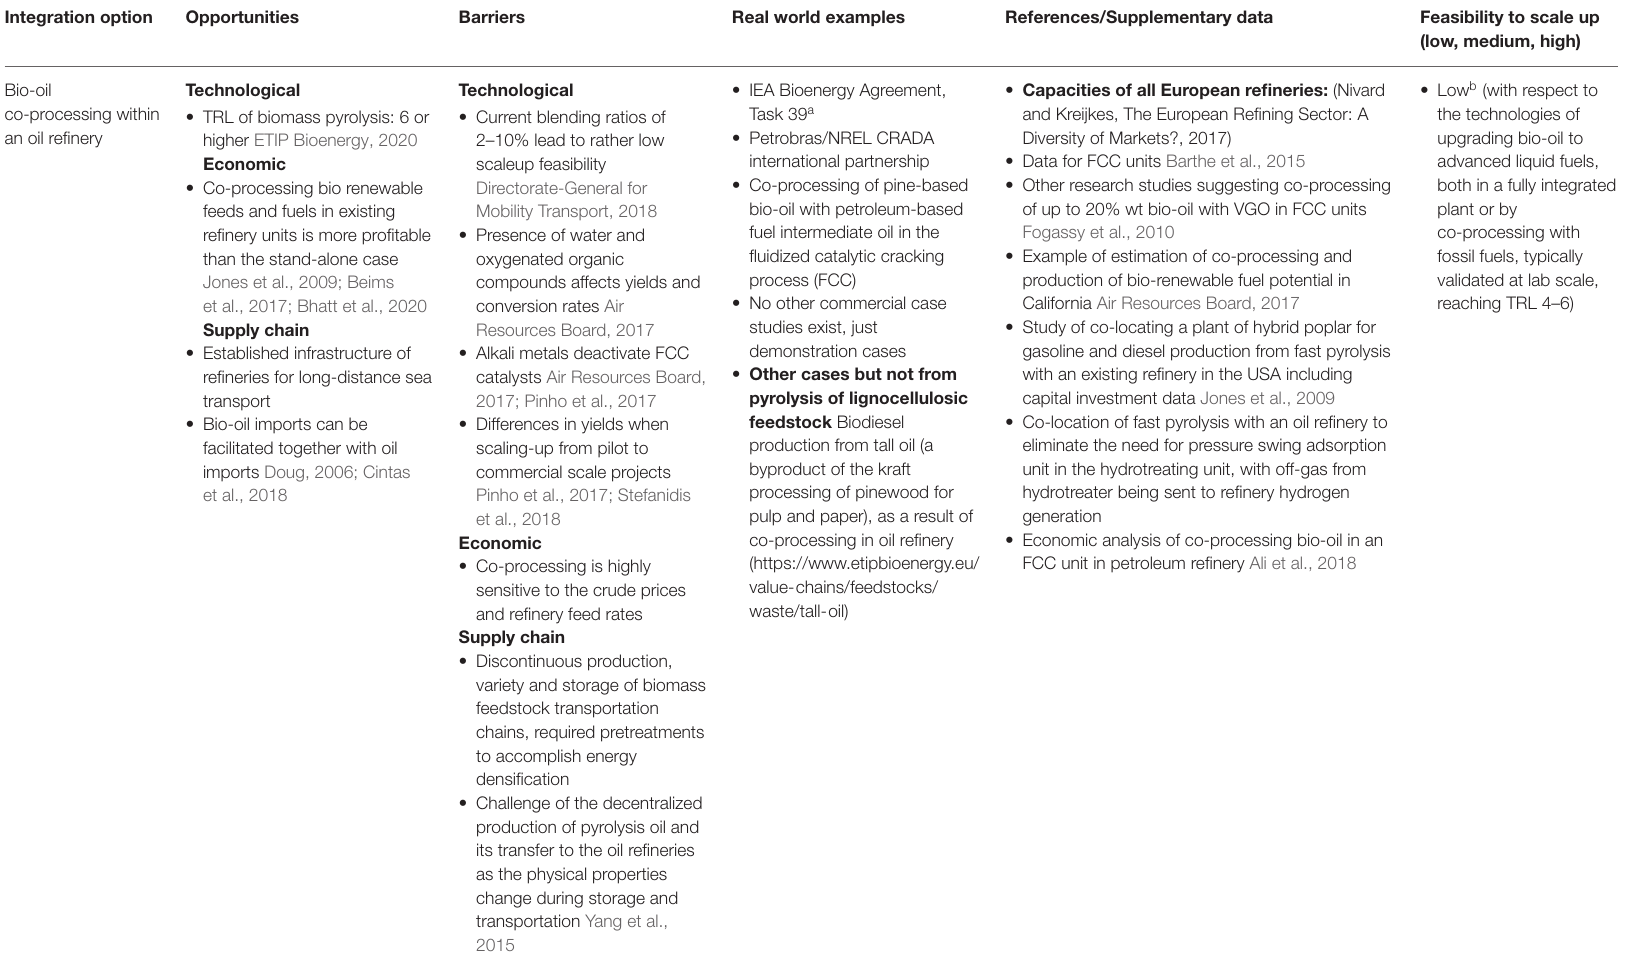
TABLE 1 | Direct integration options of biomass to liquid fuels in fossil infrastructures. Integration